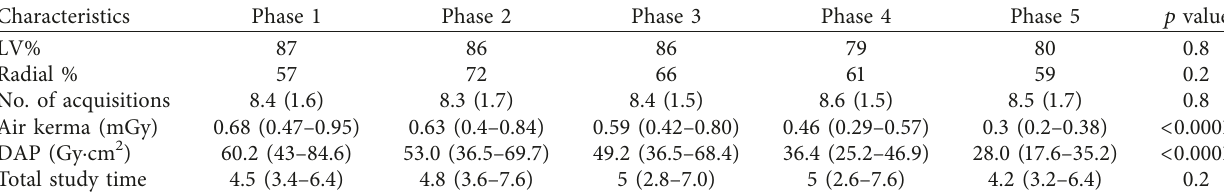
Table 3: The CA procedural characteristics of phase-specific populations.